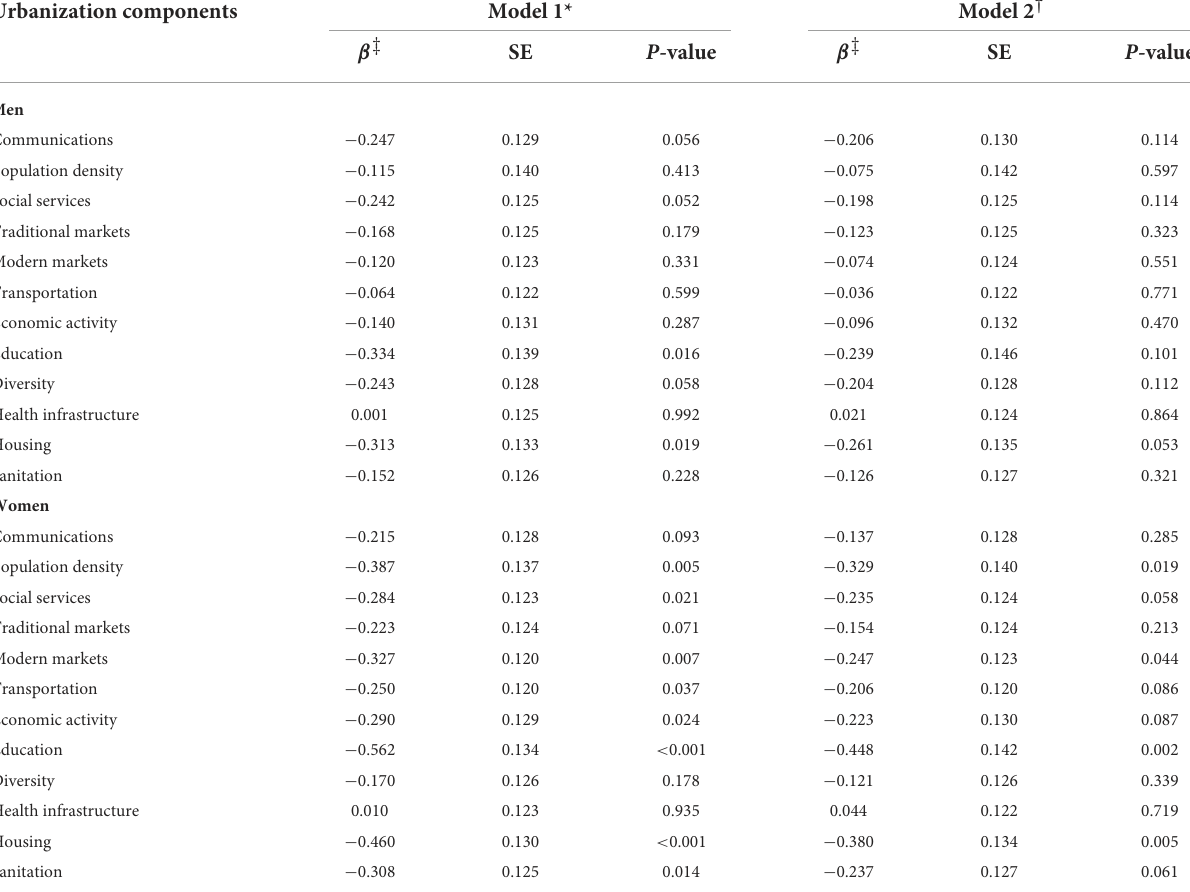
TABLE 3 Multilevel linear regression for the association between urbanization components and psychological stress, stratified by gender. Urbanization components Model 1* Model 2